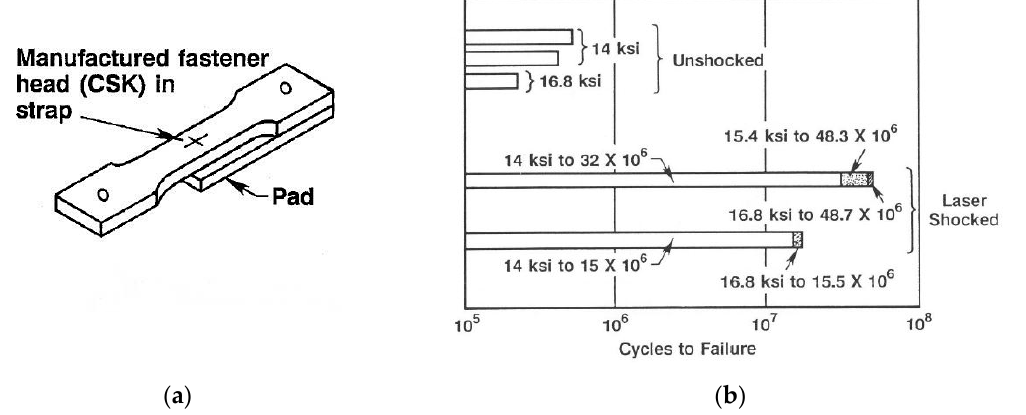
Figure 9. Fretting fatigue of 7075-T6 laser shocked and unshocked in tension with 30% load transfer, R = 0.1. (14 ksi = 96.5 MPa, 15.4 ksi = 106 MPa, 16.8 ksi = 115.7 MPa): ( a ) the test specimen; ( b ) test results. The stresses indicate steps in the applied stress [29].